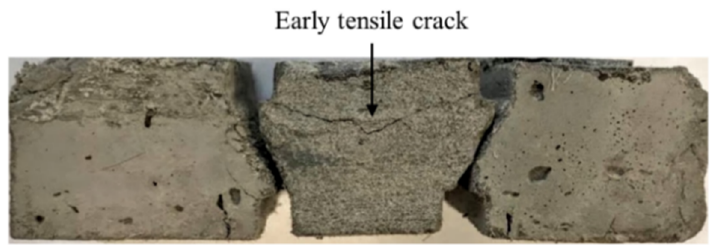
Figure 14. An example of the initial tension crack formed in the confined specimens tested under quasi-static shear loading. Table 5. Quasi-static and impact shear strengths of M1-6PE and its non-reinforced matrix (standard deviations are given in parentheses).